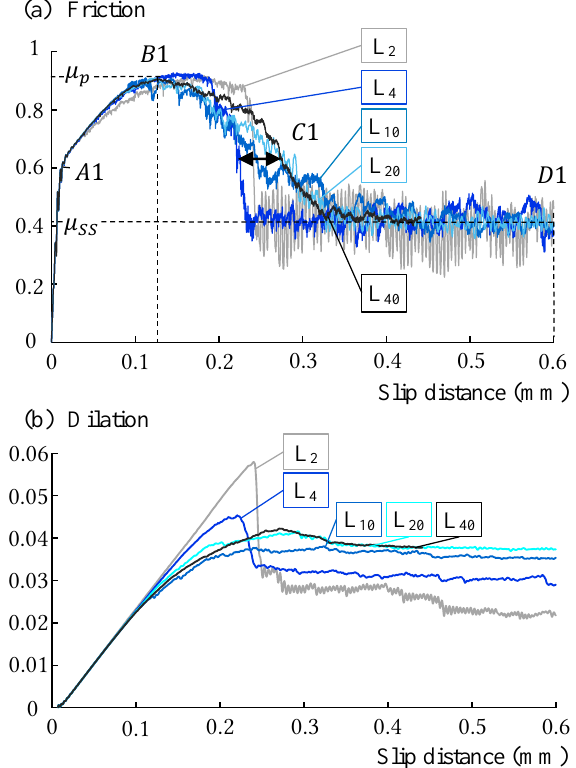
Fig. 3. (a) Friction coefficient as a function of the slip distance (mm) for different sizes of models, L 2 (2x2 mm²), L 4 (4x2 mm²), L 10 (10x2 mm²), L 20 (20x2 mm²), L 40 (40x2 mm²). 𝜇 𝑝 is the peak friction and 𝜇 𝑠𝑠 the steady state friction; (b) Dilation as a function of the slip distance (mm) for the same sizes of